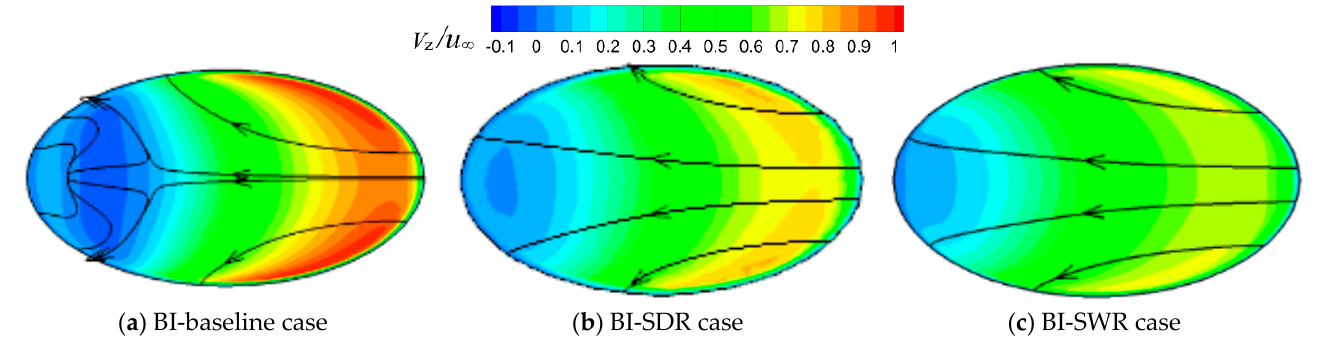
Figure 9. Dimensionless normal injection velocity contours at the film-hole exit in BI cases.